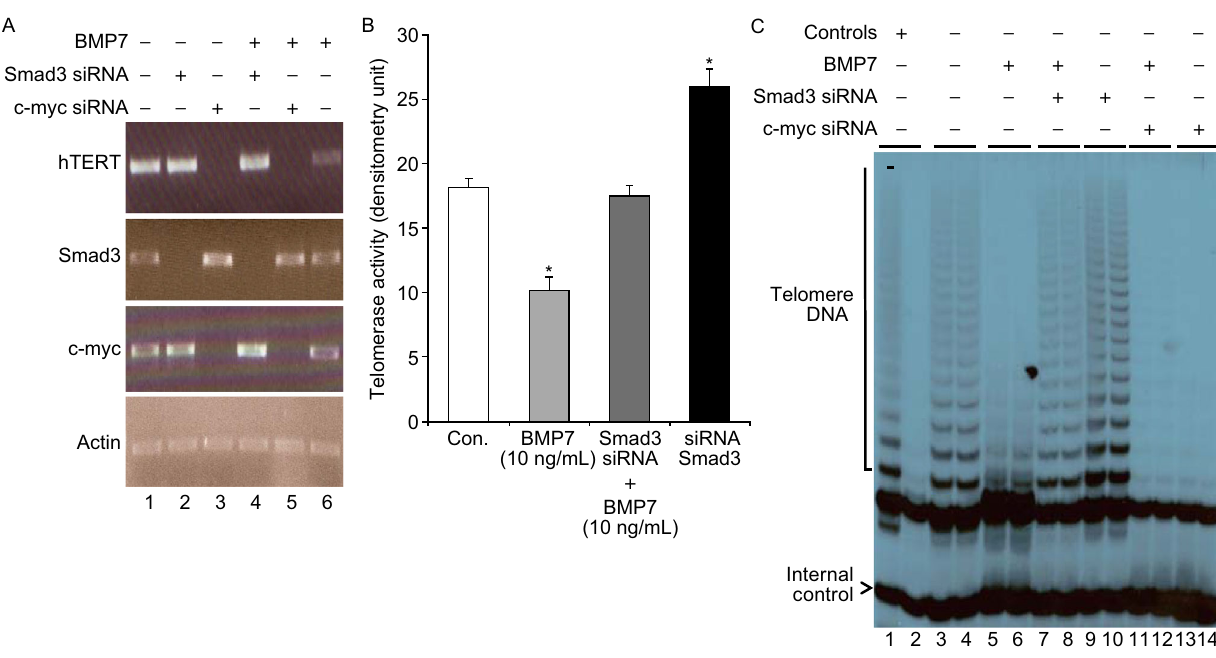
Figure 6. BMP7 induced inhibition of the hTERT gene expression and telomerase activity requires Smad3. (A) Effects of silencing Smad3 and c-myc on BMP7-induced repression of hTERT mRNA. MCF-7 cells were transfected with (lanes 2 – 6) or without (lane 1) different customer synthesized small interference RNA (siRNA) as indicated for 48 h. Cells were then treated with (lanes 4 – 6) or without (lanes 1 – 3) BMP7 (10 ng/mL) for 24 h. Gene expressions of hTERT, Smad3, c-myc and actin were determined